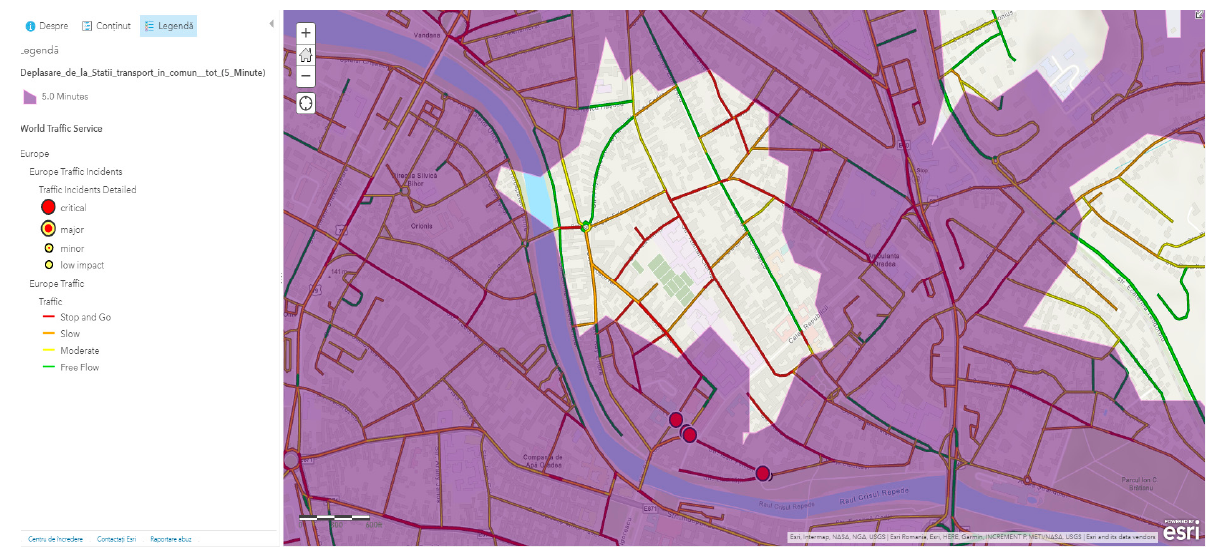
Figure 10. Traffic jams in the center due to unavailability of public transportation 4 June 2021, 2 PM (by the authors with ArcGIS Online).